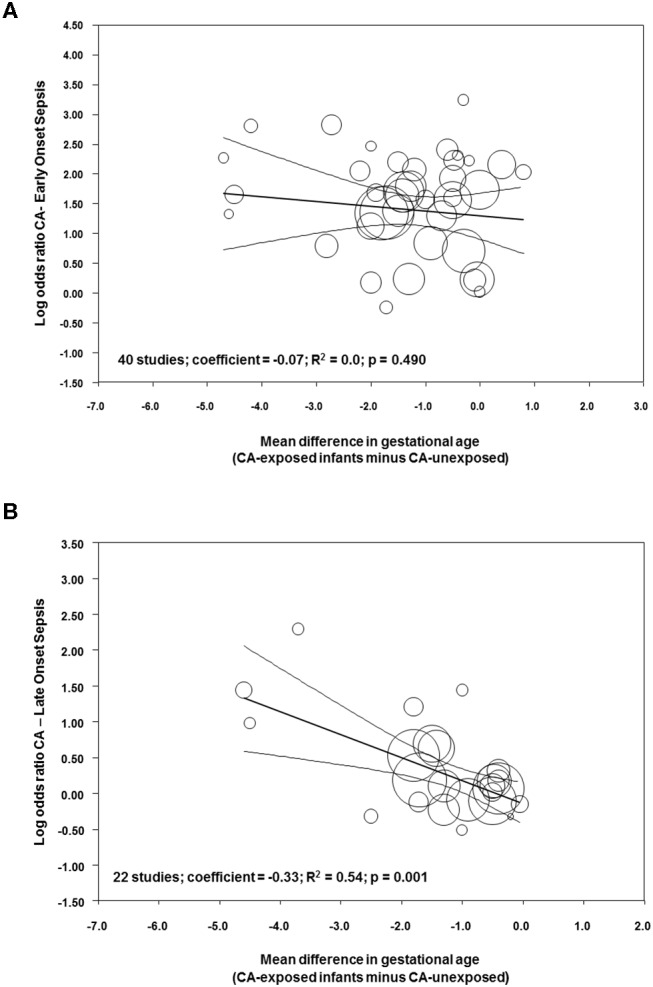
Meta-regression plot of association between chorioamnionitis and (A) early onset sepsis, and (B) late onset sepsis controlling for difference in gestational age between exposed and non-exposed groups.